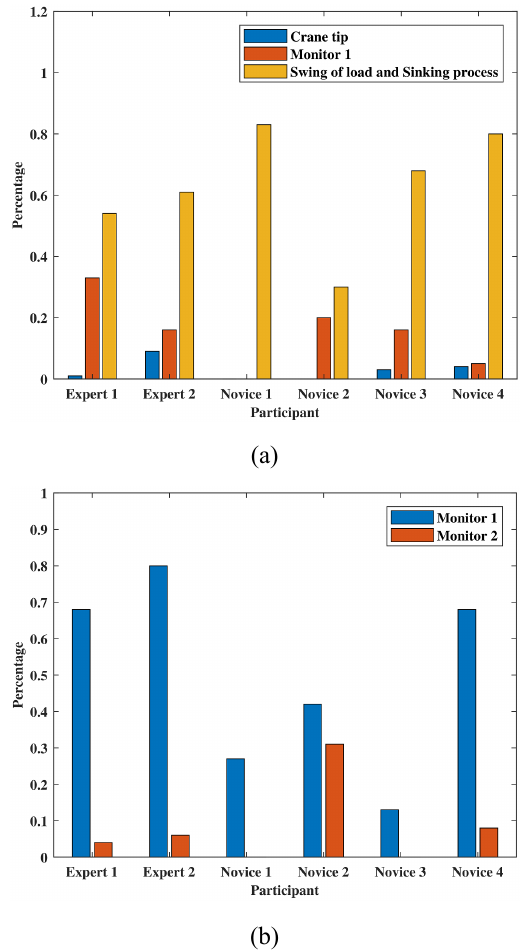
Figure 6: Fixation percentage on AOIs at (a) target stage one, and (b) target stage two.